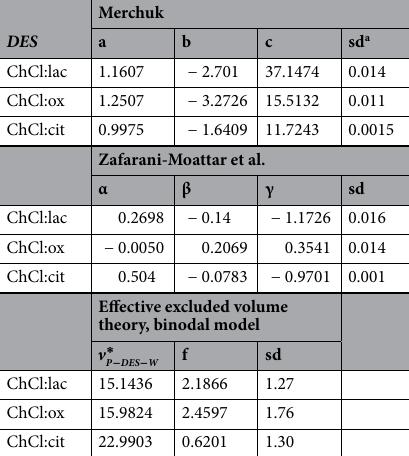
, f ), for {PPG400 + ChCl (HBA) + carboxylic − DES − W 0.5 where w1 and N represented